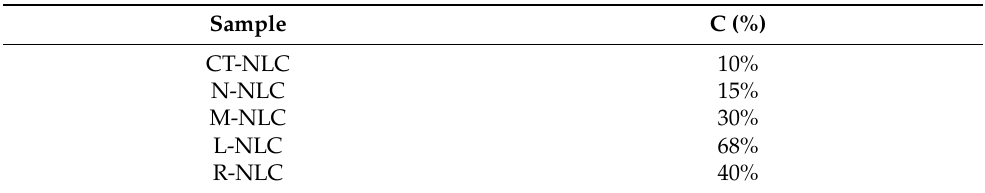
Table 5. Crystallinity (C%) of Tegosoft CT NLC (CT-NLC), Neem NLC (N-NLC), Mentha NLC (M-NLC), Lavandula NLC (L-NLC), and Rosmarinus NLC (R-NLC). Sample C